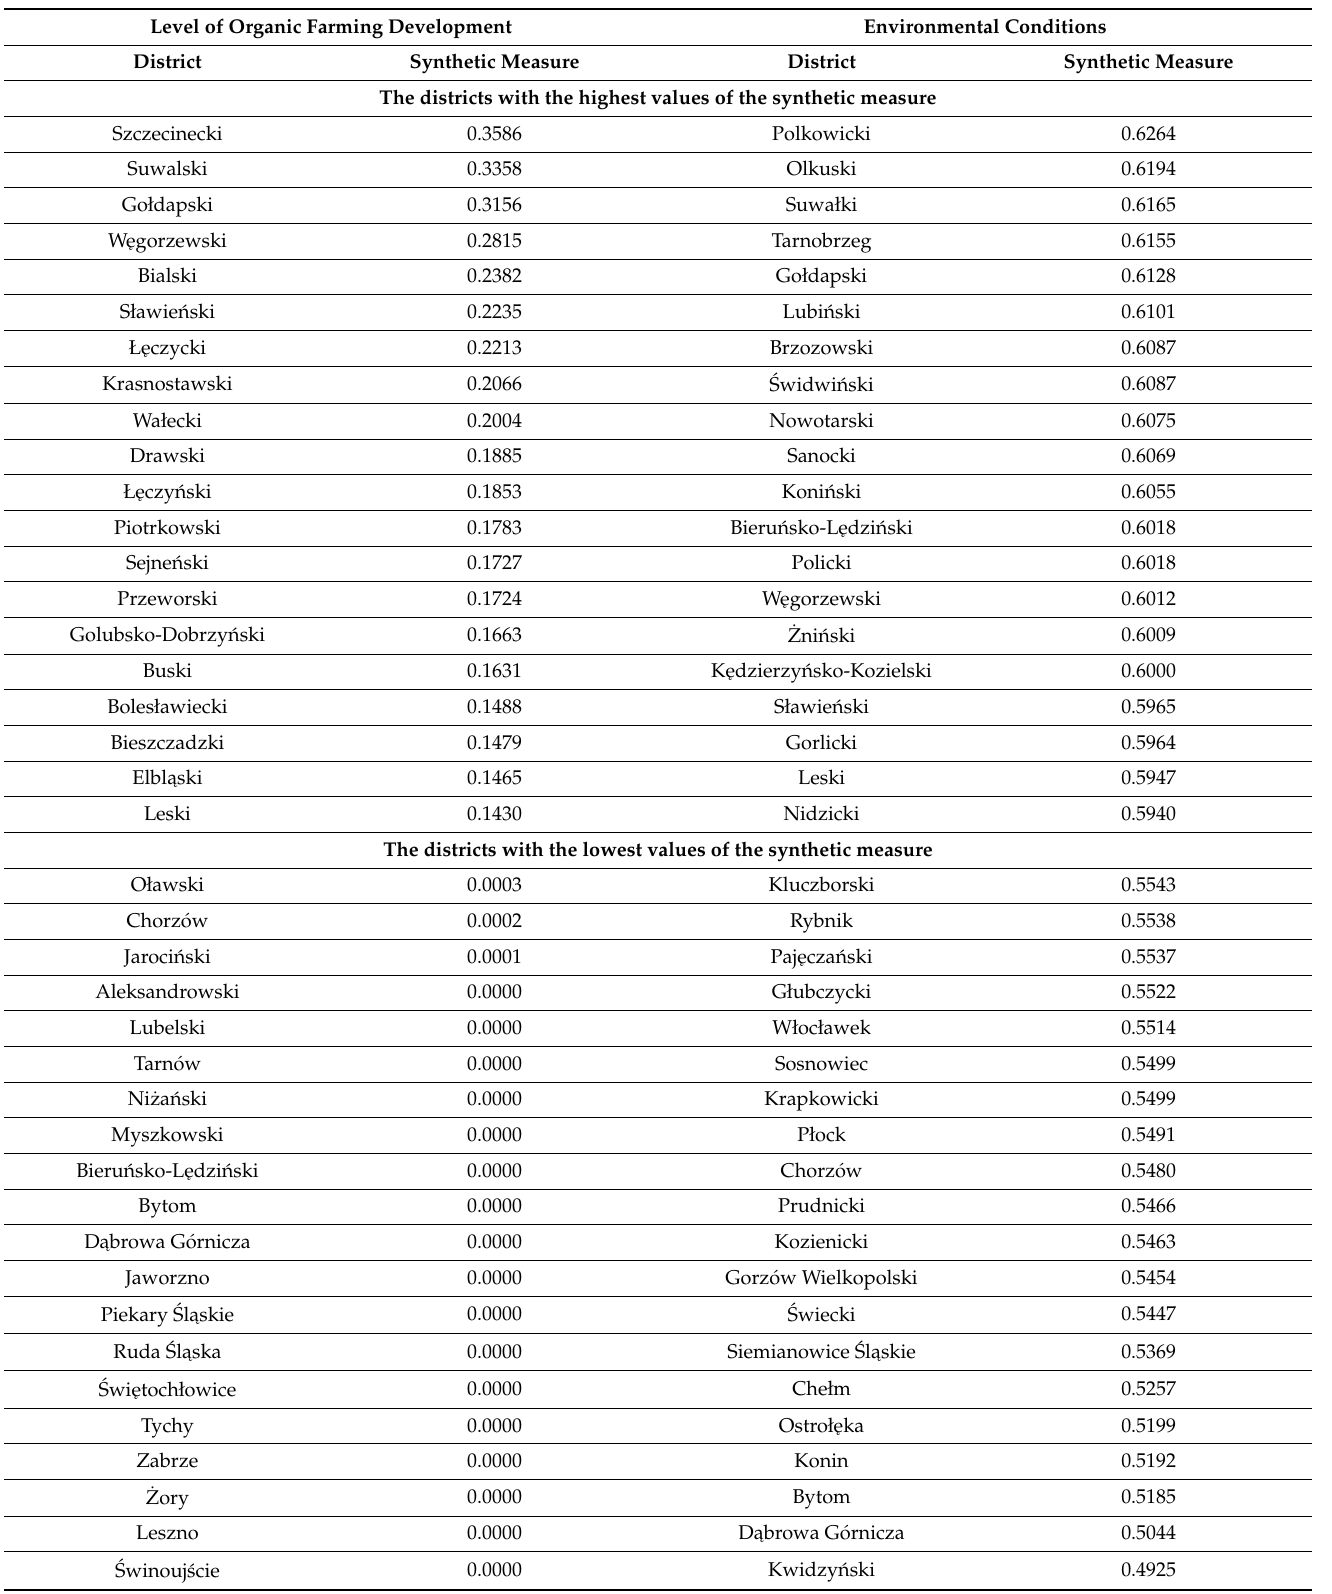
Table 3. The 20 highest and 20 lowest values of the synthetic measure related to the level of the organic agriculture development using